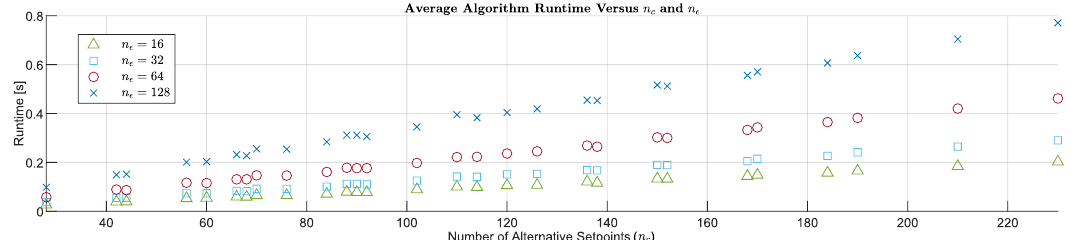
Figure 13. Variation of average RRSOAS runtimes as a function of the number of alternative government setpoints ( n c ) and the number of points that model the shape of the USV ( n (cid:101)